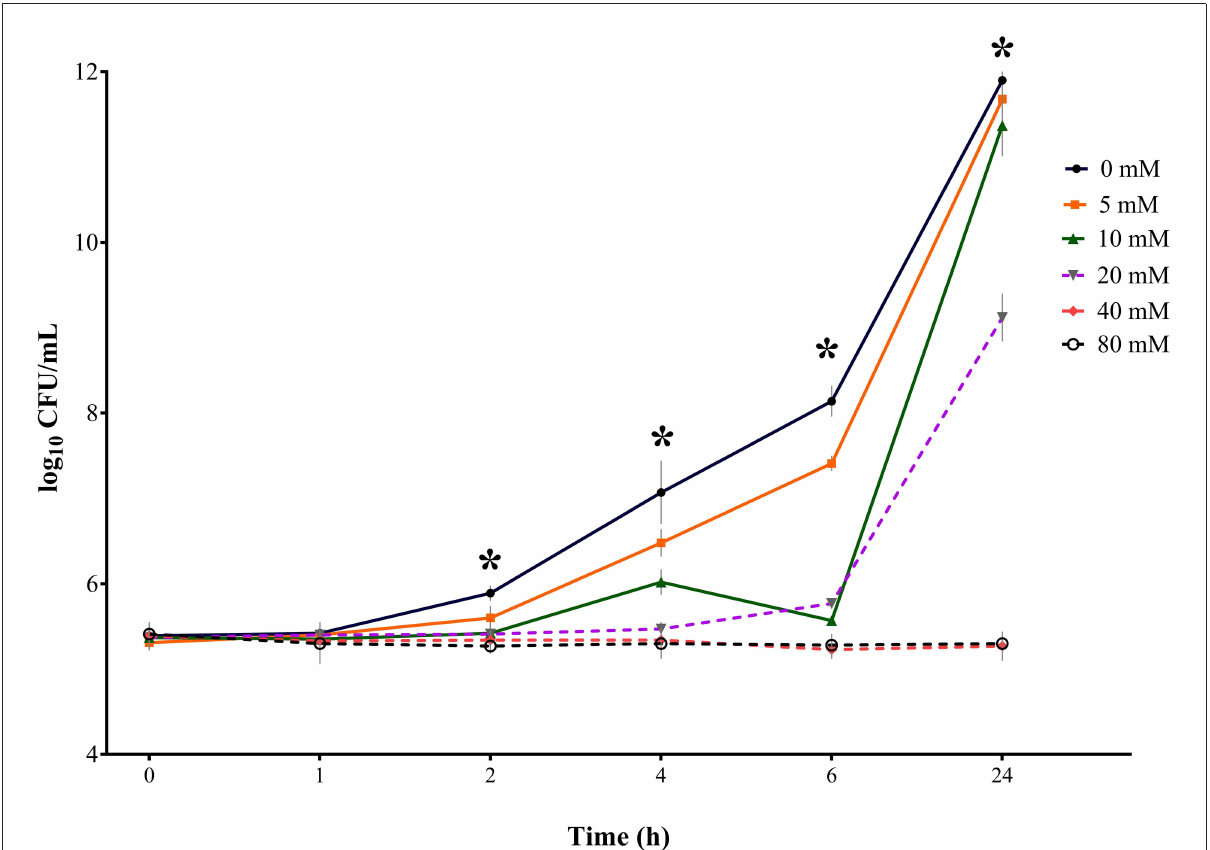
FIGURE4 Bacterial growth curves (log 10 CFU/mL) for S . Derby for three consecutive trials ( n = 3) for sodium butyrate (SB) concentrations 0, 5, 10, 20, 40, and 80mM and incubation times 0, 1, 2, 4, 6, and 24h; * indicates significant difference between concentrations ( p <